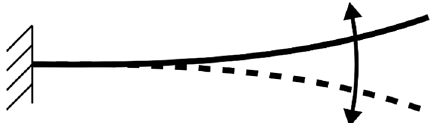
Figure 6. Cantilever beam subjected to free vibration (perpendicular to the blade chord).